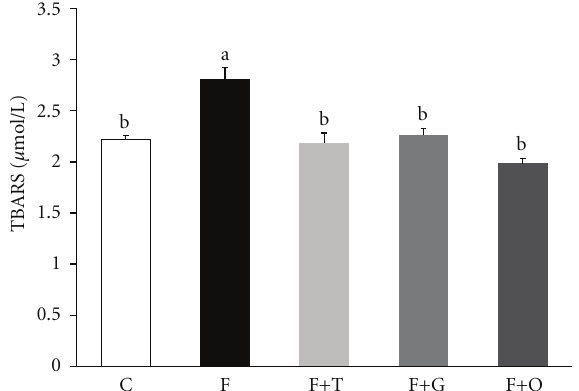
Figure 1: Plasma TBARS from C, F, F+T, F+G, and F+O groups. Values are expressed as mean ± SEM, ( n = 6); bars with di ff erent superscripts di ff er, P < 0.05.